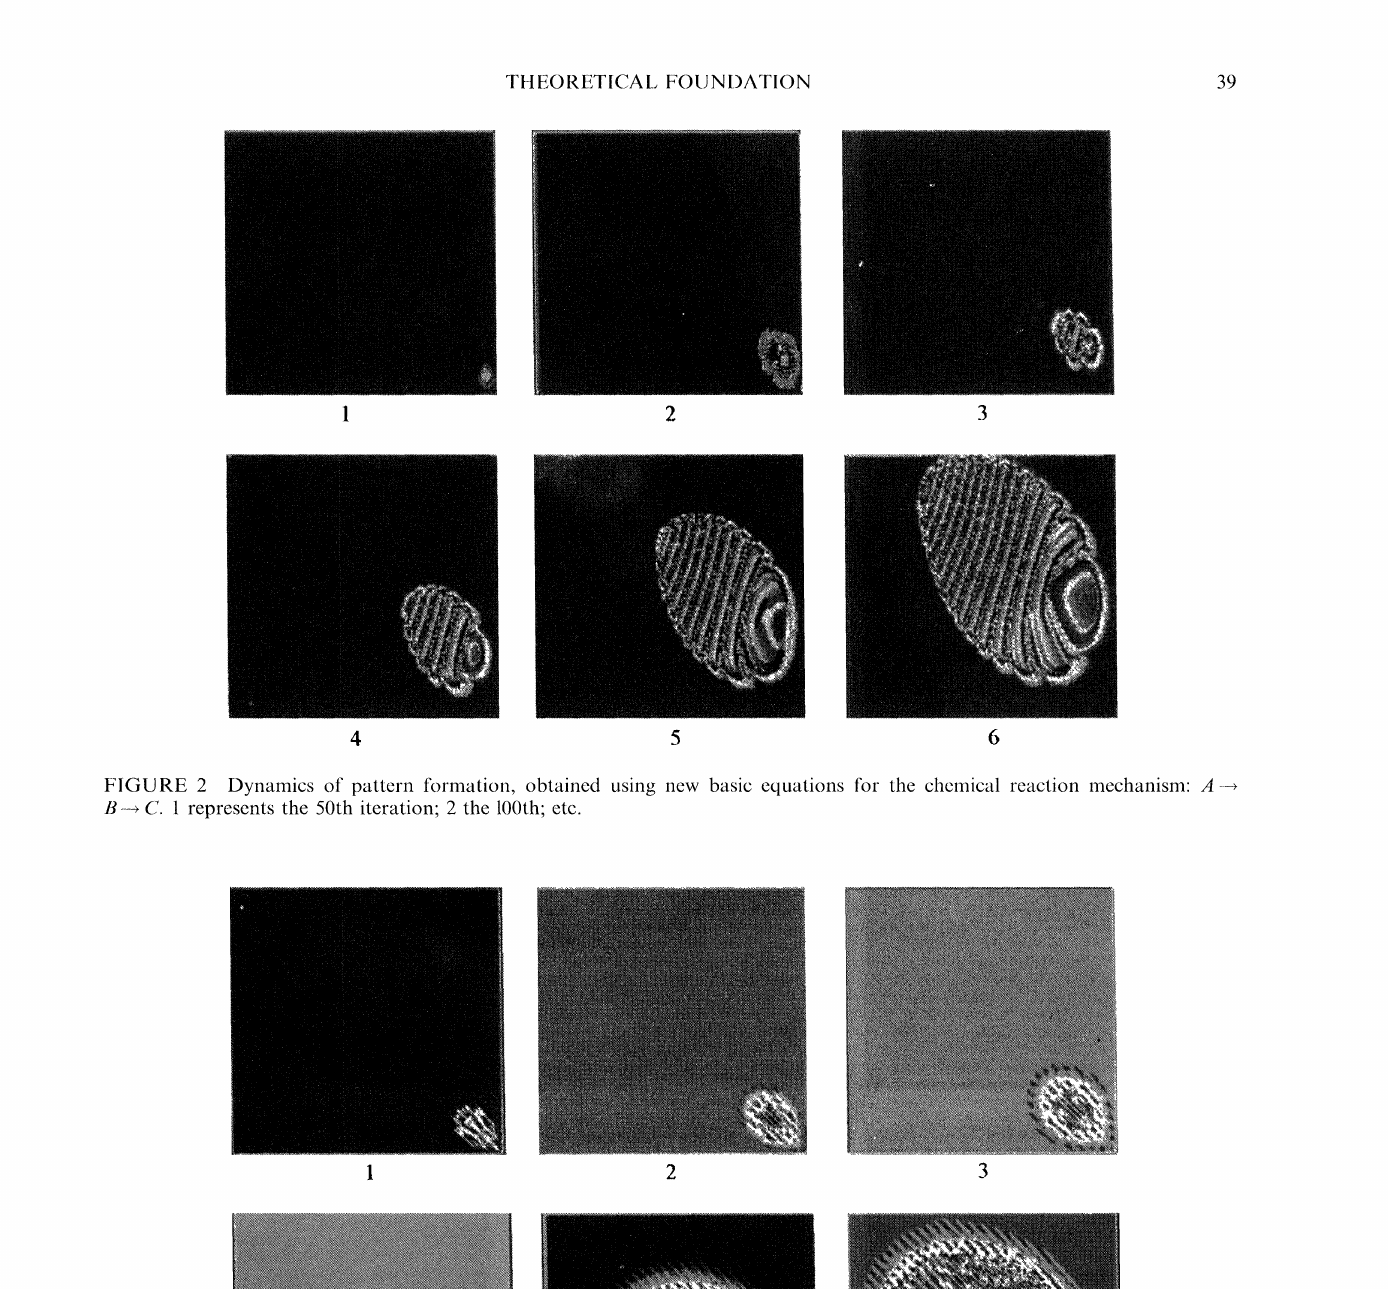
FIGURE 3 Dynamics of pattern formation for the same chemical reaction mcchanism as in Fig. 2, but using different para- meters in the mathematical